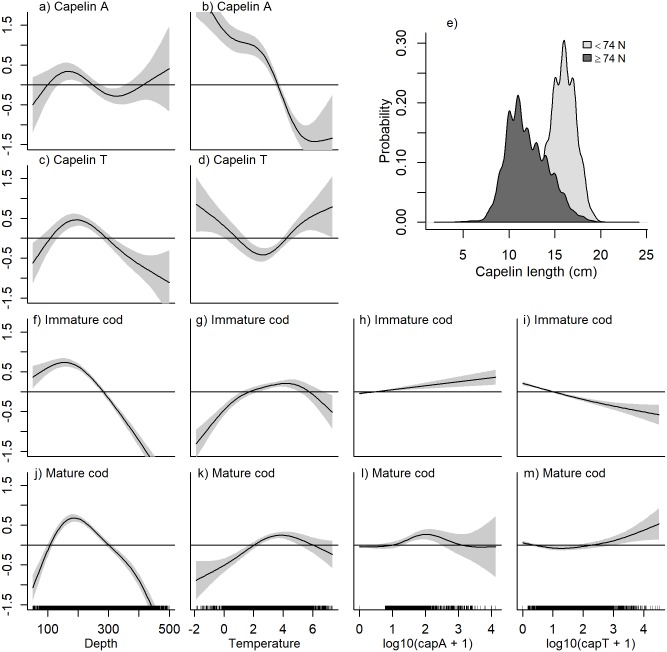
Winter GAM smooth functions from the habitat models.Non-linear regression between local densities of A-B) capelin sampled acoustically, C-D) capelin sampled with demersal trawl, F-G) immature cod, J-K) mature cod, and depth (m) and temperature (°C). The effect of local acoustic (log10[NASC+1]) and trawl capelin (log10[ind x nmi-2+1]) densities from the extended habitat models are shown for H-I) immature cod and L-M) mature cod. The plot shows the (centered) log local species density as a function of the covariate when accounting for the other covariate effects. The horizontal line at 0 corresponds to a neutral contribution of the covariate to the response. The grey bands illustrate ± 2 standard errors around the smooth estimate. Panel E) shows probability density distributions of capelin length in demersal trawl hauls south and north of 74°. The distributions were calculated from the catch numbers of capelin in each 1 cm-length group using R base function “density” with default settings. Capelin matures at approximately 14 cm [23].